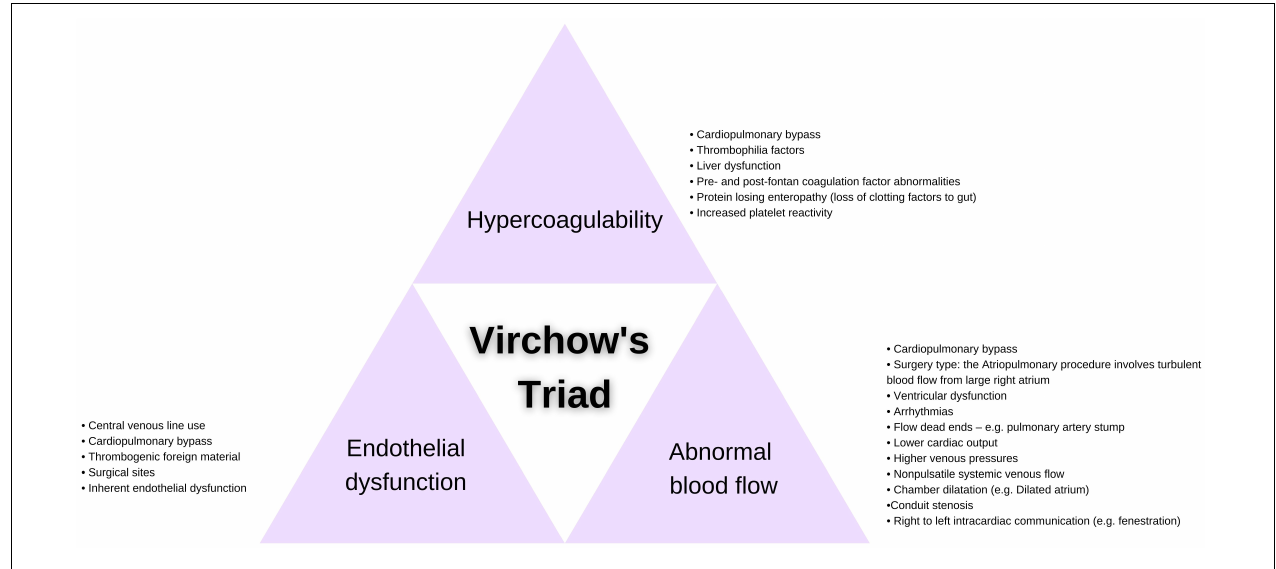
FIGURE 1 | Contributors to Virchow’s triad present in Fontan